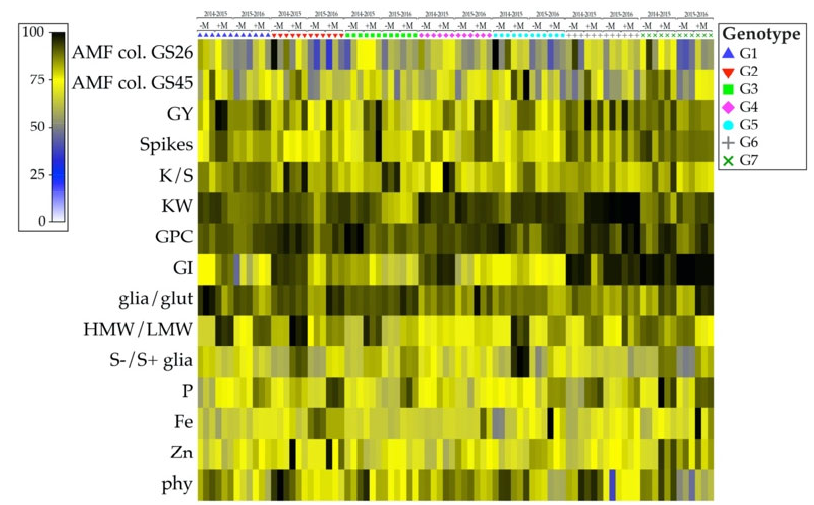
Figure 8. Shade plot based on arbuscular mycorrhizal fungal colonization, yield and yield components, and proteins and minerals in grain, highlighting variable patterns in mock ‐ AM fungal inoculated ( − M) wheat genotypes (G) and AM fungal inoculated (+M) G in the two years of cultivation (2014/2015 and 2015/2016). The input data matrix was square rooted, and data were standardized by the total value of the variables (parameters). For genotype (G), codes refer to Table 1. Parameters are: AMF root colonization (AMF col.) at the end of tillering (G26) and at booting growth stages (GS45); GY: grain yield; Spikes: spike density; K/S: number of kernels per spike; KW: kernel weight; GPC: grain protein concentration; GI: gluten index; glia/glu: glia ‐ din ‐ to ‐ gluten ratio; HMW/LMW: HMW ‐ GS ‐ to ‐ B ‐ type LMW ‐ GS ratio; S − /S+ glia: sulphur ‐ poor to ‐ sulphur ‐ rich gliadin fractions ratio; P: grain phosphorus concentration; Fe: grain iron concentration; Zn: grain zinc concentration; phy: phytates concentration in grain. The quantity parameters are shown by depth/colour of shading from white to black (scale from 0 to 100). Wheat genotypes: G1: Gentil Rosso; G2: Risciola; G3: Frassineto; G4: Autonomia B; G5: Verna; G6: Blasco; G7: Bologna.